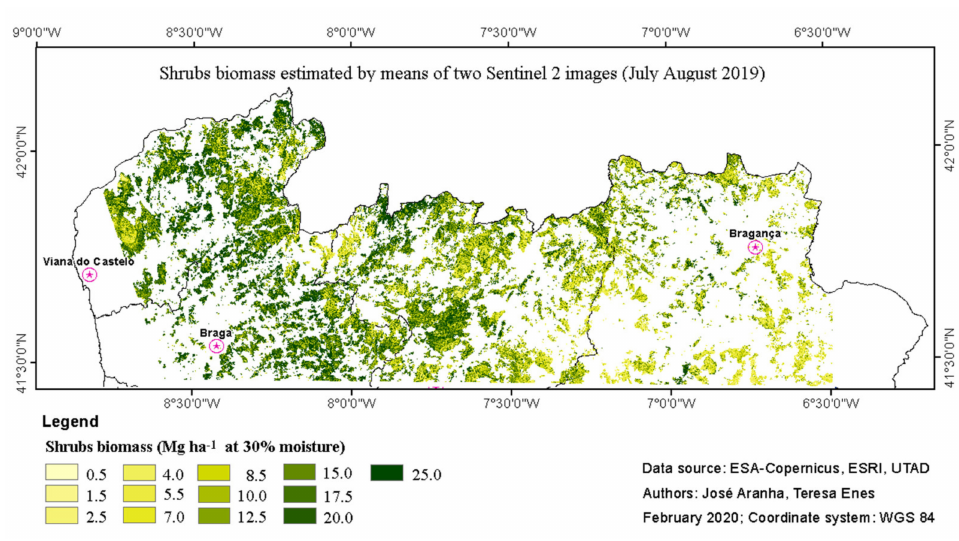
Figure 8. Accumulated shrubs’ biomass in former burnt areas in the North of Portugal, estimated using an NDVI image summer 2019 and an allometric